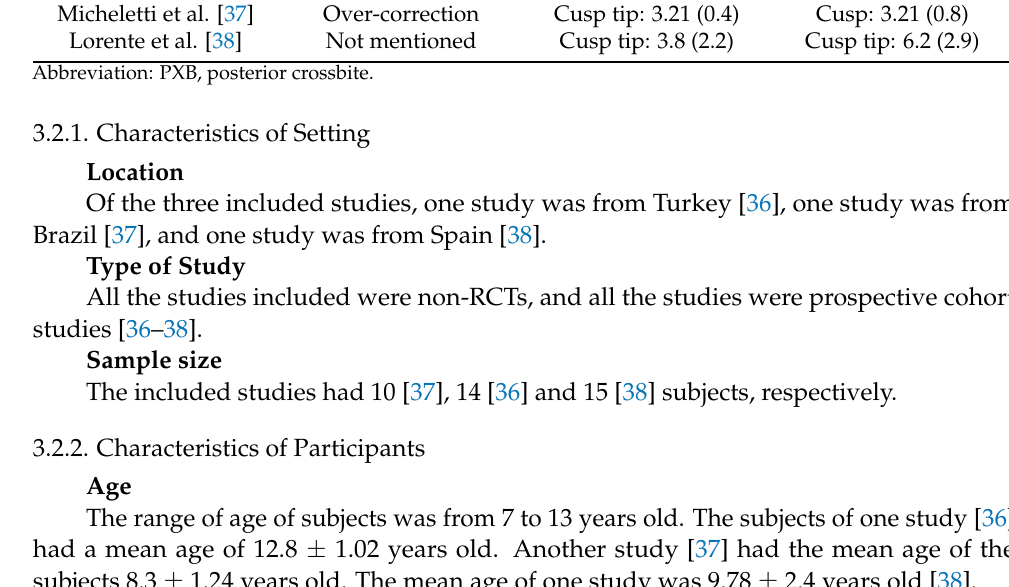
Table 2. Correction of bilateral PXB and the changes in the intercanine and intermolar width after palatal expansion. Correction of Intercanine Width Intermolar Width Study Bilateral PXB (mm) (mm) Memikoglu et al. [36] Not mentioned Cusp tip: 3.42 Cusp tip: 5.42 Micheletti et al. [37] Over-correction Cusp tip: 3.21 (0.4) Cusp: 3.21 (0.8) Lorente et al. [38] Not mentioned Cusp tip: 3.8 (2.2) Cusp tip: 6.2